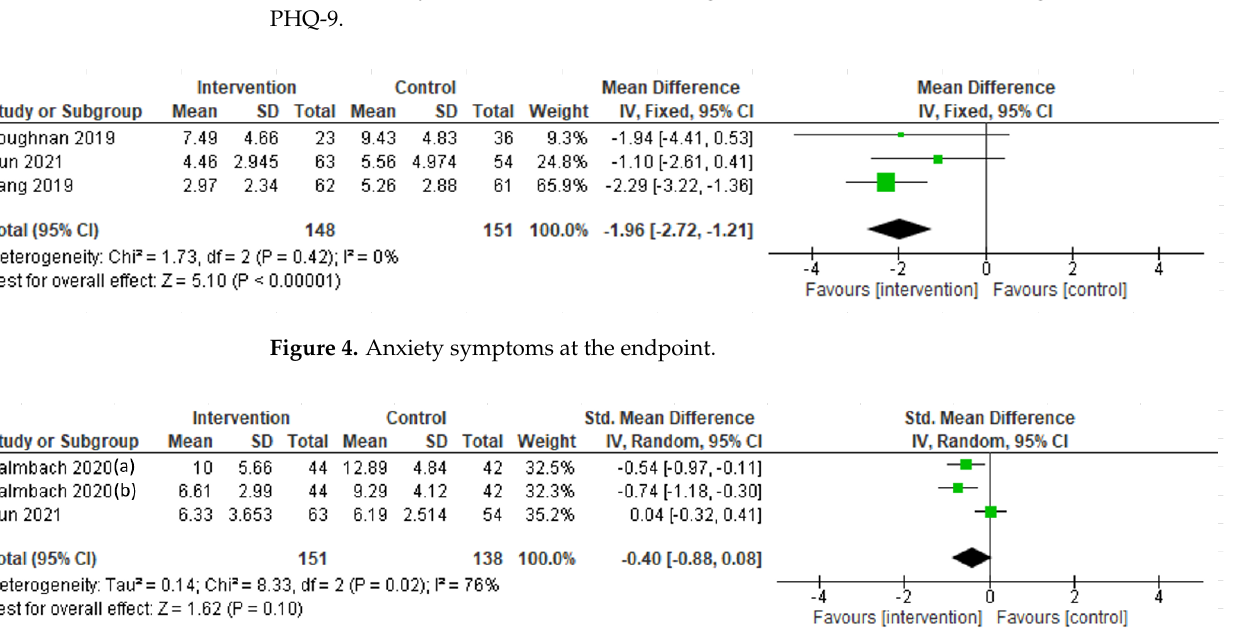
Figure 6. Sleep quality at the 6-month postpartum follow-up: Kalmbach 2020 (a, [66]) = ISI; Kalmbach 2020 (b, [66]) = PSQI. 3.4. Publication Bias The publication bias was assessed for depression symptoms, as the outcome was evaluated by all included studies (Figure 7). The Egger regression test was performed, highlighting no publication bias (β0 = 1.23; 1 -tail p = 0.10). Accordingly, no further analyses were carried out. Figure 7 . Funnel plots assessing publication bias for depression symptoms. -2,0